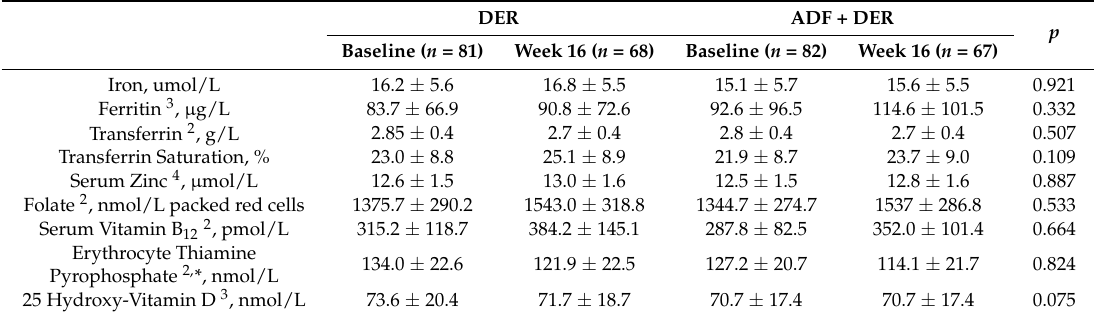
Table 4. Markers of nutritional status in the DER and ADF + DER groups before and after the 16-week energy restriction intervention 1 .